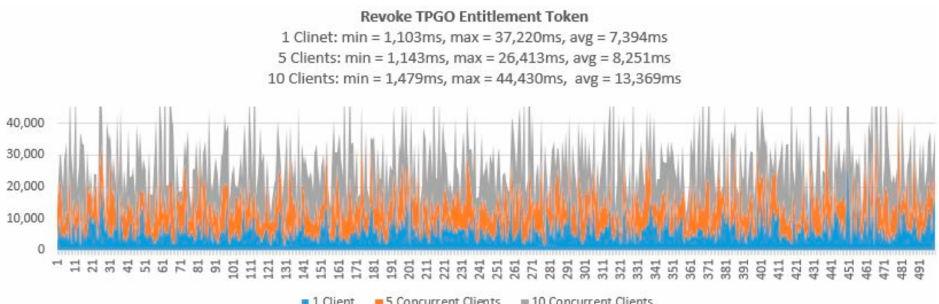
Figure 17. Response times from Revoke TPGO Entitlement Token for 500 calls.